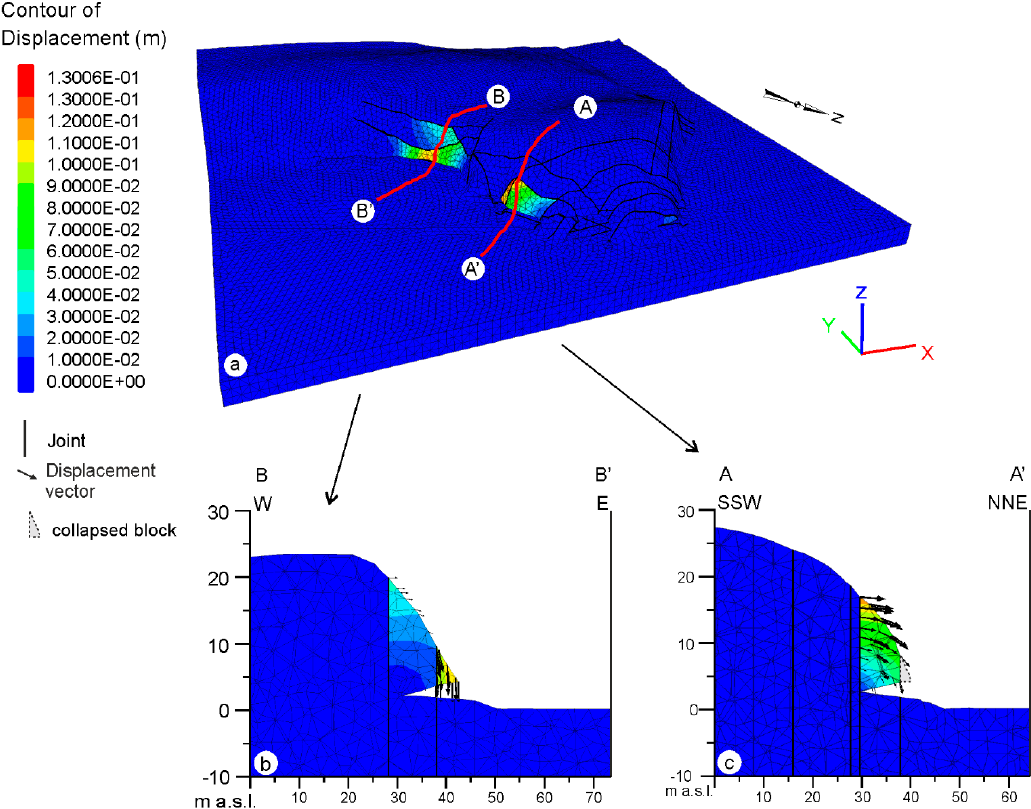
Figure 17. ( a ) The displacement contours and vectors of the pre-landslide model of the Punta Lunga cliff; ( b ) the A-A’ section; and ( c ) the B-B’ section.